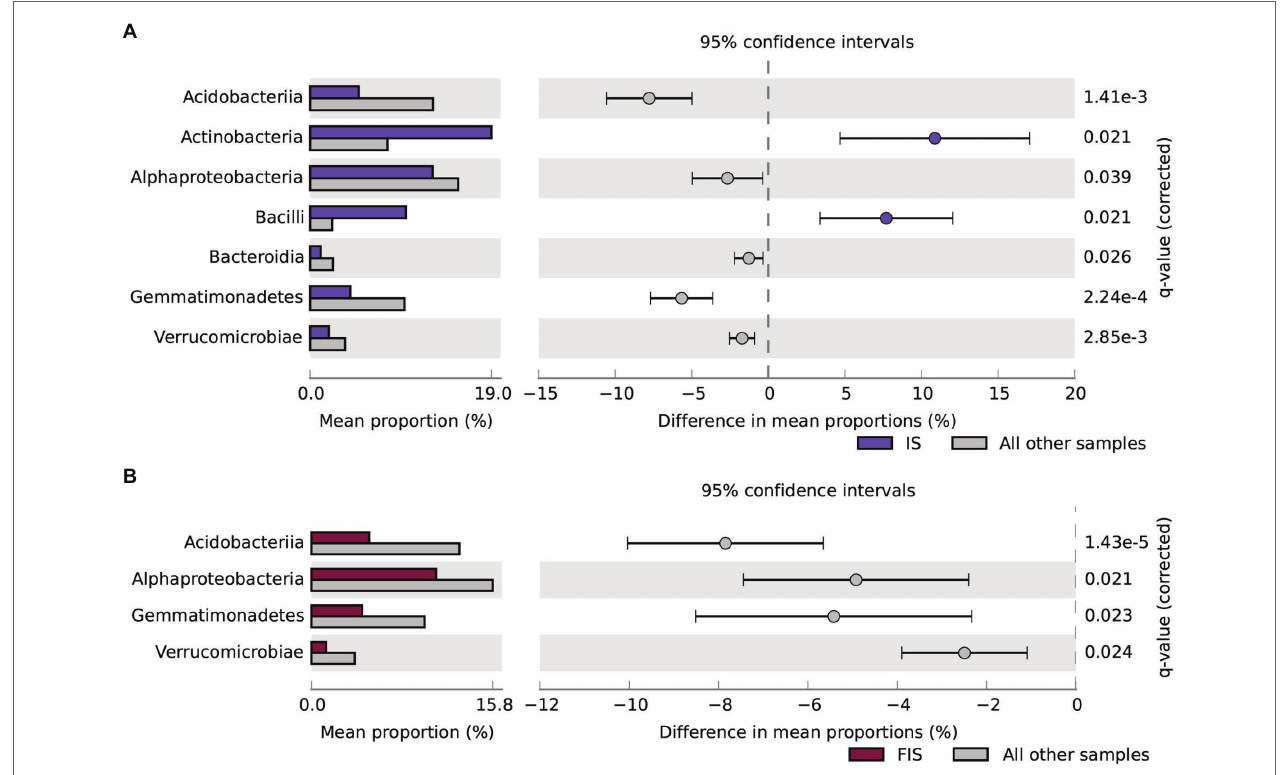
FIGURE 7 | Statistical differences of representative microbial communities at the class level from the rhizosphere at V15. (A) A. brasilense inoculant at seed sowing + Maize stover coverage (IS) against all other treatments; (B) Urea-topdressing fertilization at V5 + A. brasilense inoculant at seed sowing + Maize stover coverage (FIS) against all other treatments. Classes overrepresented in IS and FIS (colored/dark) correspond to positive differences among proportions, and other samples (gray/light) correspond to negative differences among proportions. Error bars are the standard deviations. The q -values were calculated using the Storey FDR approach ( p < 0.05) with effect size filter in difference among proportions ( DP <